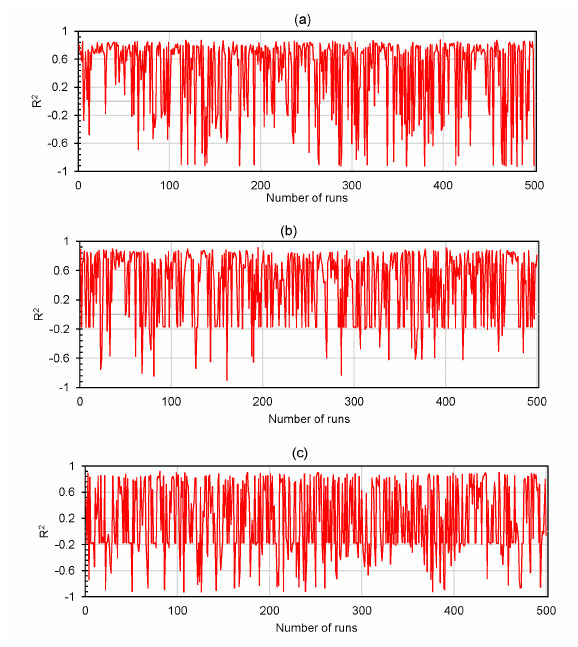
Fig. 6. Parameters tuning using RS with: (a) 1 hidden layer; (b) 2 hidden layers; (c) 3 hidden